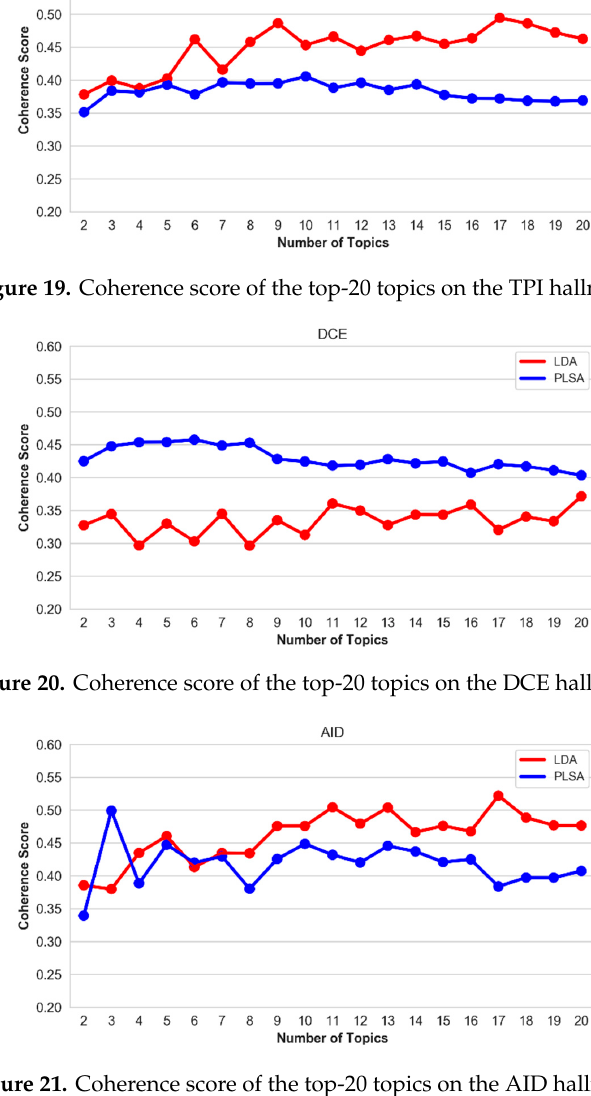
Figure 21. Coherence score of the top-20 topics on the AID hallmark.